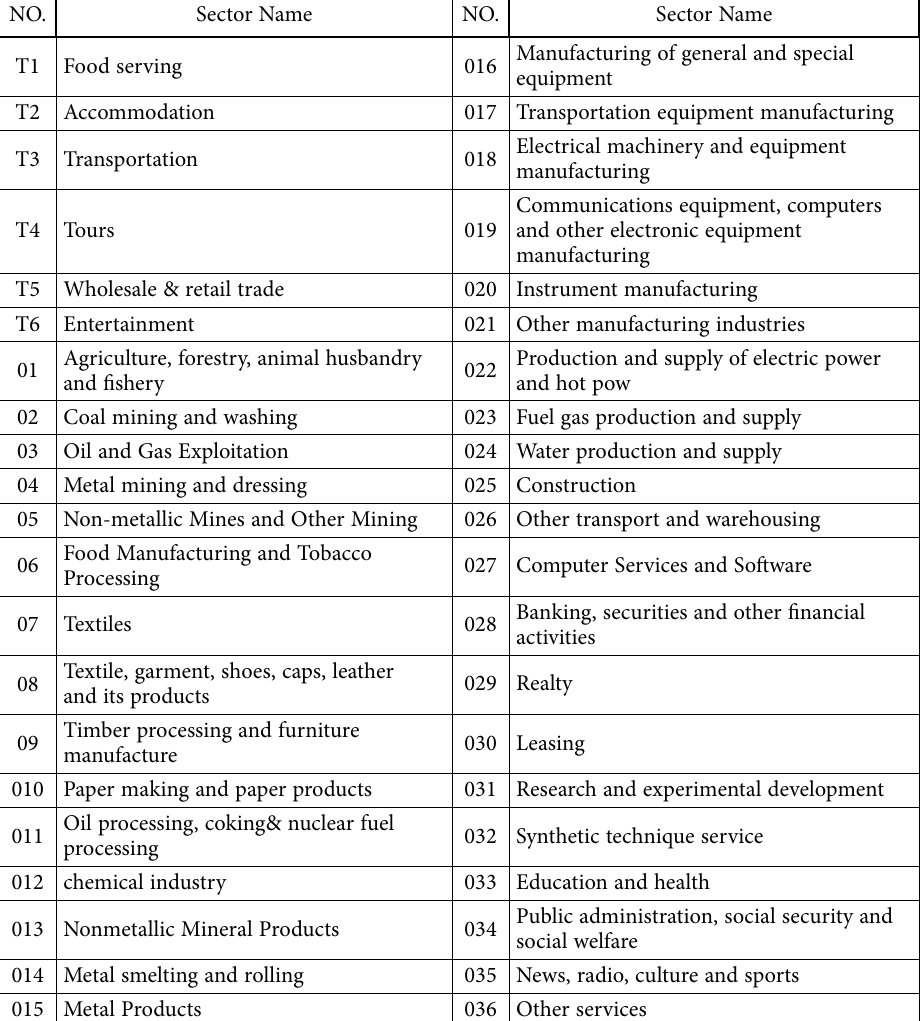
Table 5. Sectors categories and descriptions of adjusted IO table